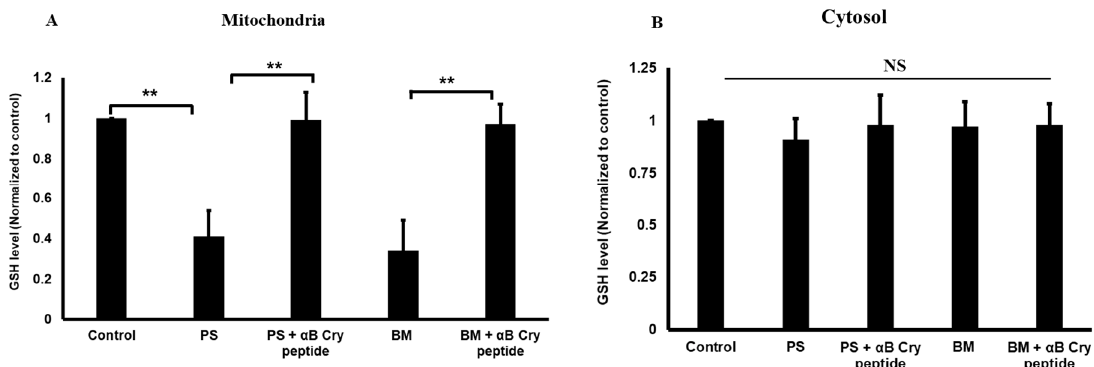
Figure 4. Inhibition of mGSH carrier proteins results in the depletion of mGSH levels of RPE. hRPE cells were incubated with OGC and DIC inhibitors in the presence or absence of α B cry peptide as described for Figure 1. Mitochondria and cytosolic fractions were separated, and GSH levels were measured in mitochondrial ( A ) and cytosolic fractions ( B ) by colorimetry and were normalized to controls. mGSH levels were significantly decreased with inhibitors only in the mitochondrial fraction while no significant changes were observed in the cytosol of RPE cells. Cotreatment with α B cry peptide restored mGSH levels to that of control levels. Data are shown as mean ± SEM of four independent experiments. ** p < 0.01; NS = not significant.